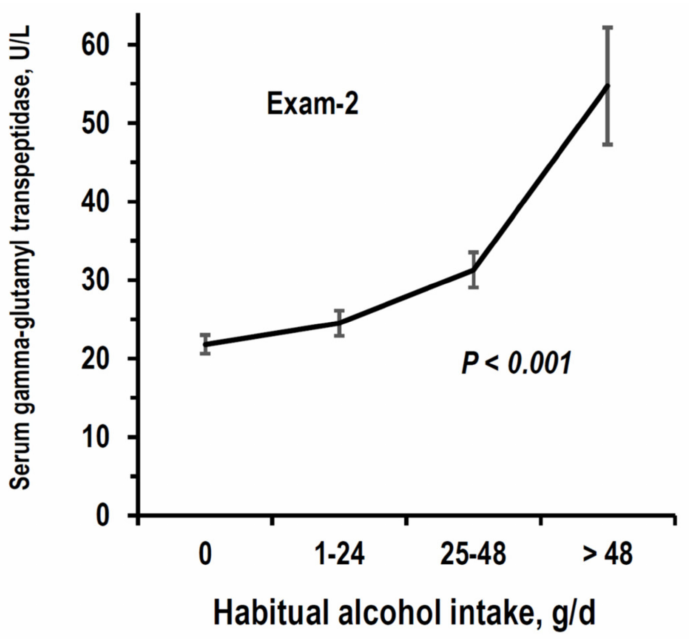
Figure 4. Mean and 95%CI of serum gamma-glutamyl transpeptidase by stratum of alcohol intake (g/d = g/day) at Exam-2. Number of examinees per stratum is reported in Table 1. p -value is from non-adjusted